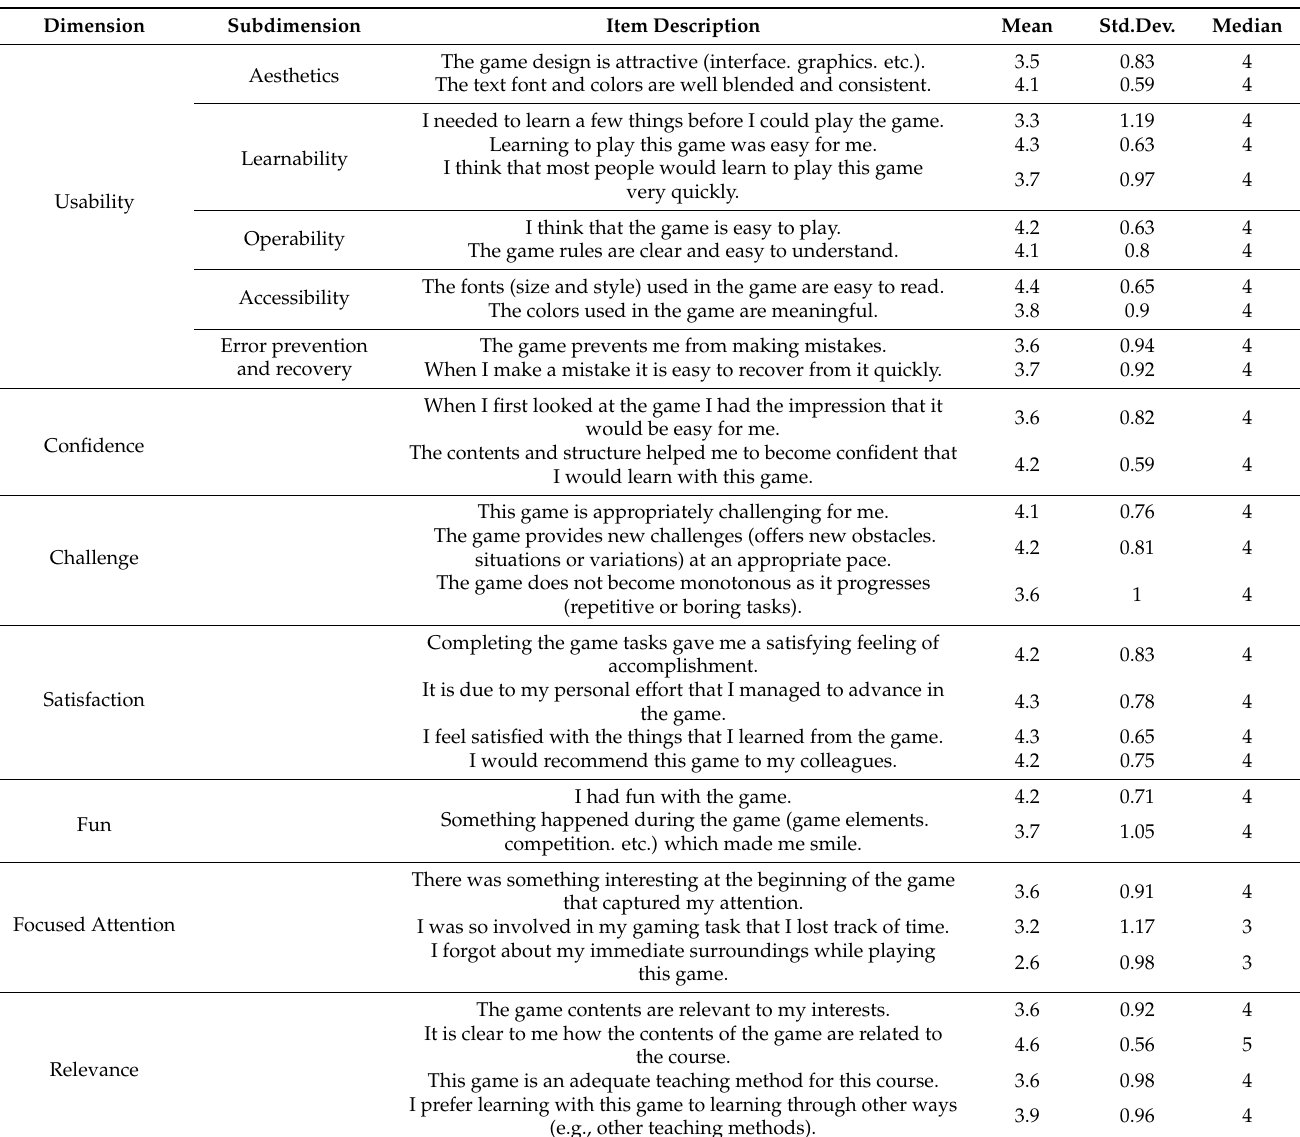
Table 3. Results regarding player